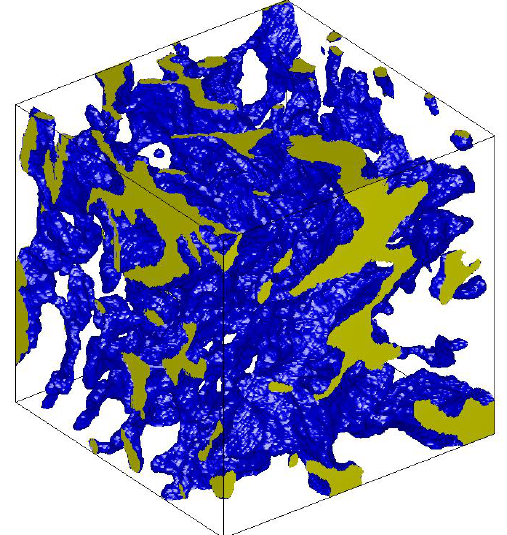
Figure 1. 3D reconstructed microstructure (replica) of filter F1 as a subregion of 200  200  200 voxels (0.5 micron/voxel). Pore orifices are yellow, pore-metal interface is blue, and metal phase is